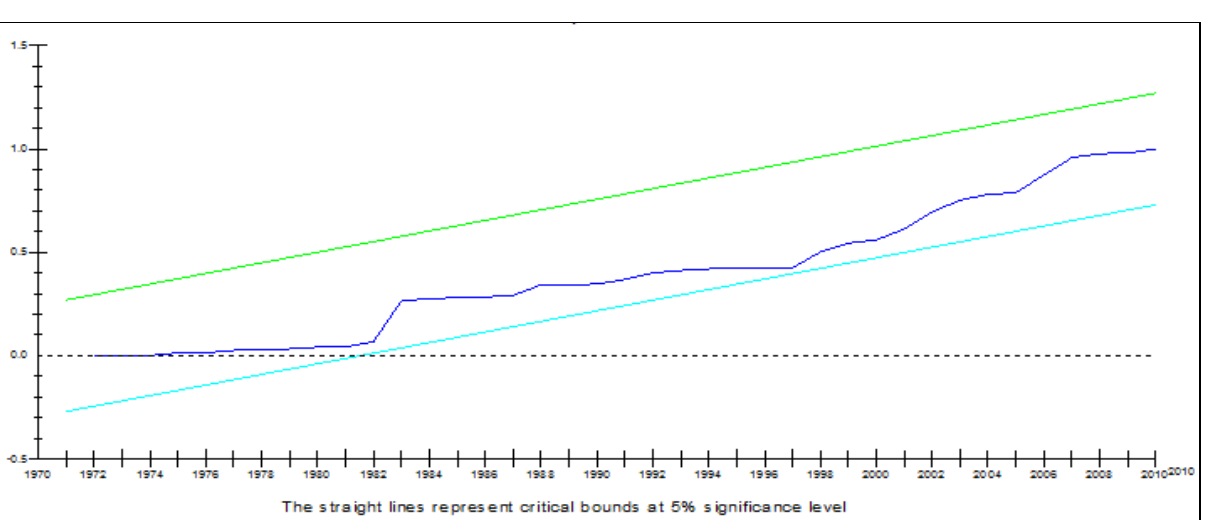
Fig. A1. Plot of Cumulative Sum of Recursive Residuals (CUSUM)